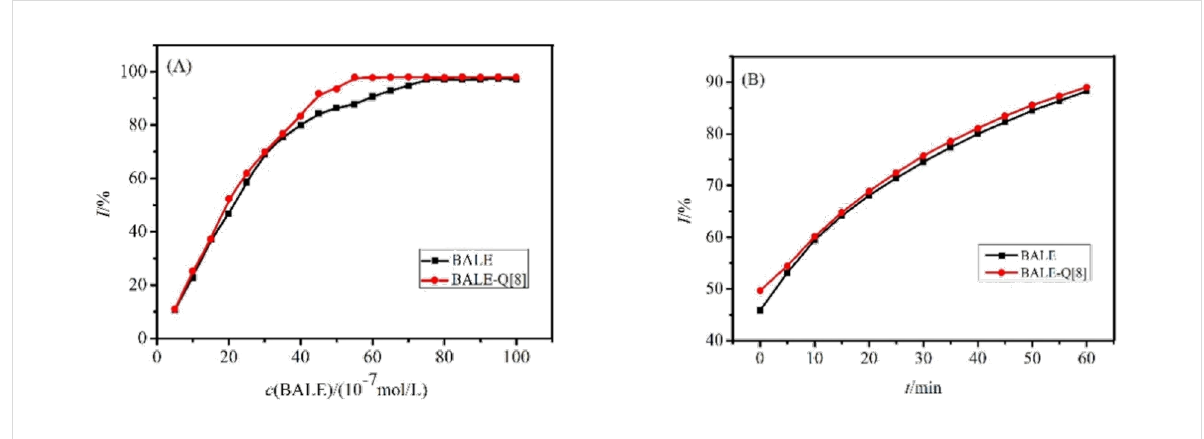
Figure 9: The clearance rate curve (A) and clearance time curve (B) of ABTS +· upon increasing the concentration of BALE and the BALE–Q[8] inclu- sion complex.